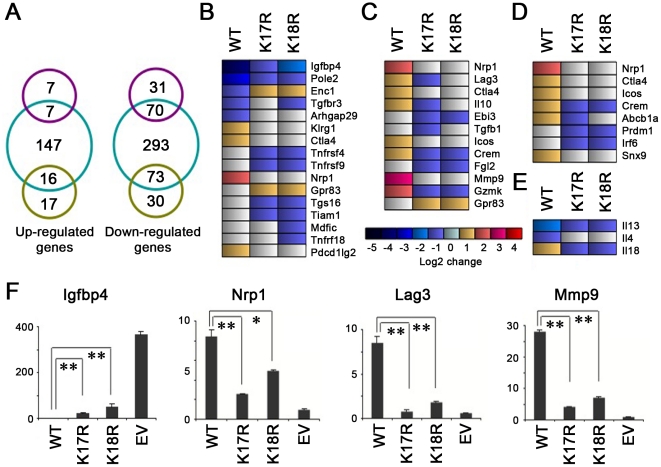
Comparison of gene expression profiles of CD4+ T cells transduced with WT Foxp3, K17R, K18R or EV.(A) Venn diagrams summarizing overlapping upregulated (left) or downregulated (right) gene expression profiles of CD4+ T cells transduced with WT Foxp3 (blue), K17R (purple) or K18R (yellow) compared with CD4+ T cells transduced with EV (cutoff was set as Log2 fold >1). (B–E) Heat maps showing gene expression profiles of CD4+ T cells transduced with EV, WT Foxp3, K17R or K18R. (B) Heat maps showing distinct Treg ‘signature’ gene expression profiles. (C) Heat maps indicating the change in gene expression profiles of Treg cell identified and putative suppressive genes. (D) Heat maps indicating the distinct gene expression profiles of Foxp3 directly bound genes. (E) Heat maps indicating distinct gene expression profiles of Treg-related cytokine genes. (F) qPCR assays of Treg-specific genes selected from microarray analyses; results are representative of 3 independent experiments, and *p<0.05, **p<0.01 compared to WT Foxp3.